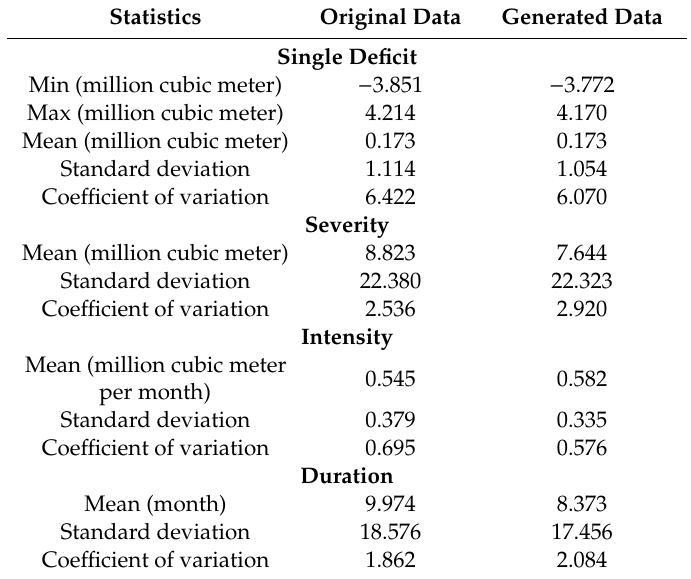
Figure 6. Relative frequency distribution of the deficit water. Table 1. Statistical properties of original data versus generated data for city of Fort Collins.